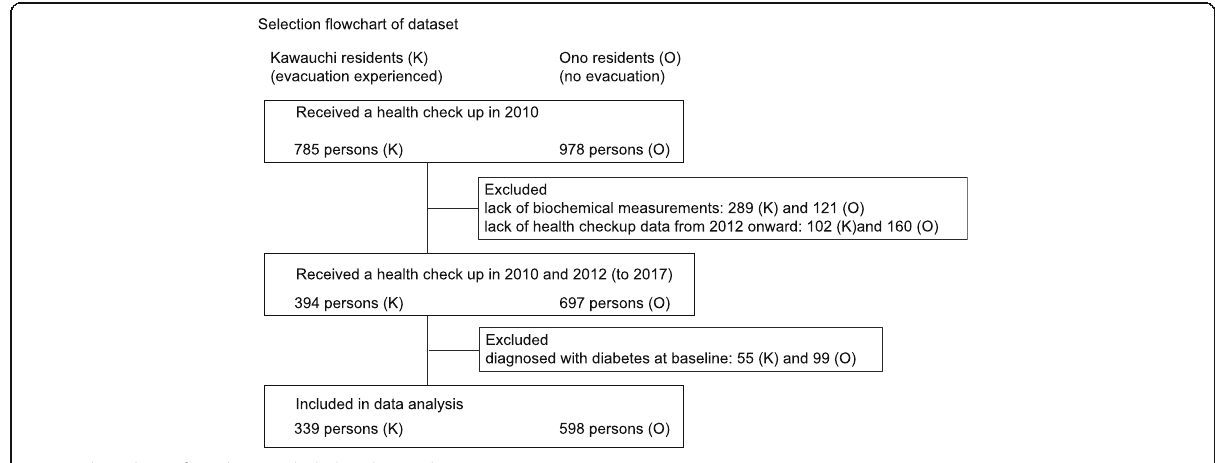
Fig. 2 Flow-chart of residents included in this study